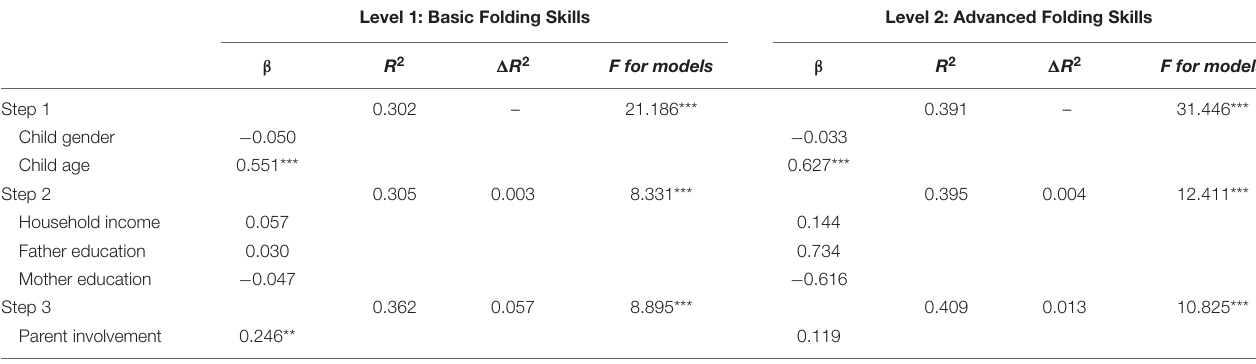
TABLE 4 | Summary of hierarchical regression analyses predicting paper folding skills.